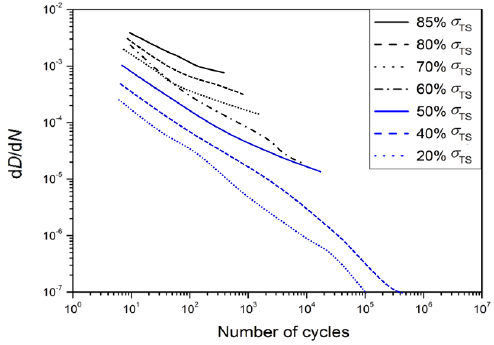
Figure 8. The rate of change of homogeneous damage, d D at different cyclic stress levels [3].